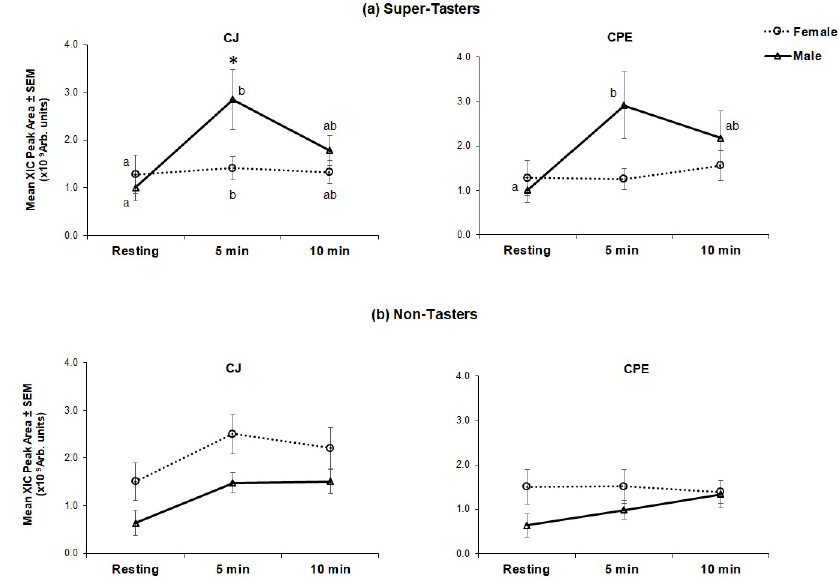
Figure 3. E ff ect of stimulation on total bPRP (basic proline-rich protein) levels in taster by gender subgroups. Mean extracted ion current (XIC) peak areas ± SEM ( × 10 9 arbitrary units) are shown for super-taster ( a ) and non-taster subjects ( b ). Left panels show response to stimulation to CJ, while right panels show response to CPE. The same resting values were used for CJ and CPE. Superscripts ( a,b ) show significant di ff erences in protein levels across the time course in each subgroup (male ST, female ST, male NT or female NT) and * shows di ff erences between males and females at each time point. Non-taster females ( n = 15), non-taster males ( n = 14), super-taster females ( n = 16) and super-taster males ( n =